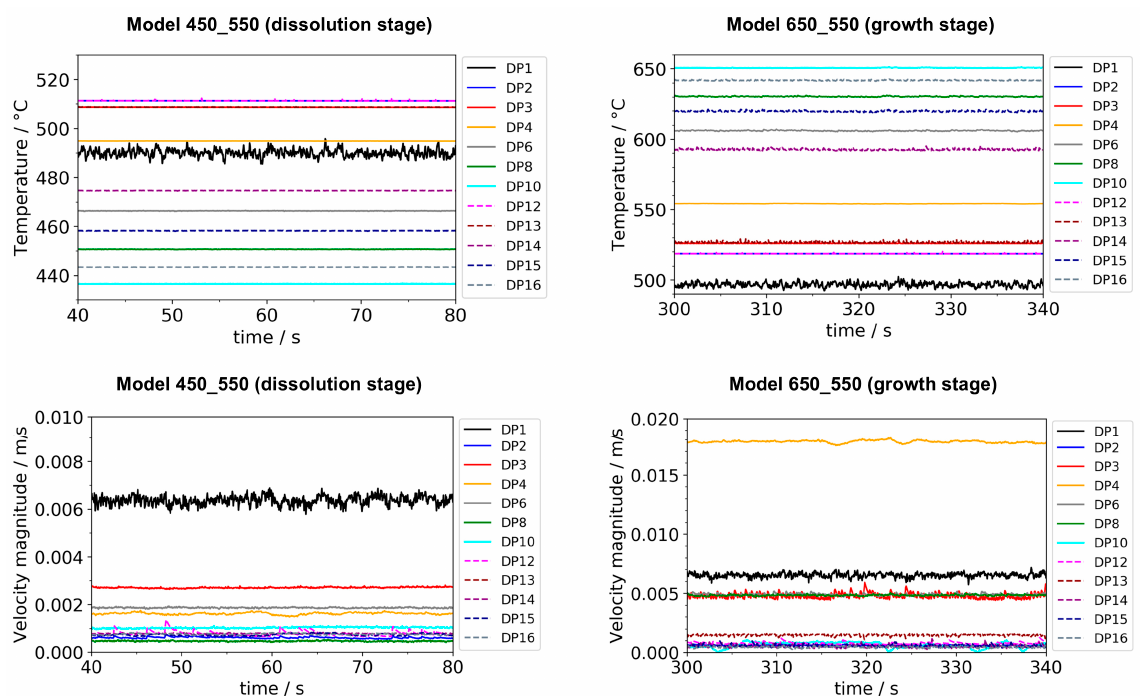
Figure A1. Temperature (top) and velocity magnitude (bottom) over time for all probe locations in the fluid at dissolution stage (left) and growth stage (right), respectively. Note the different y-axis scales at growth and dissolution stage. Data were exported with a temporal resolution of 0.05 s. Note that the times shown here should be interpreted only in terms of time range, as they do not relate to the time values elsewhere in this work.